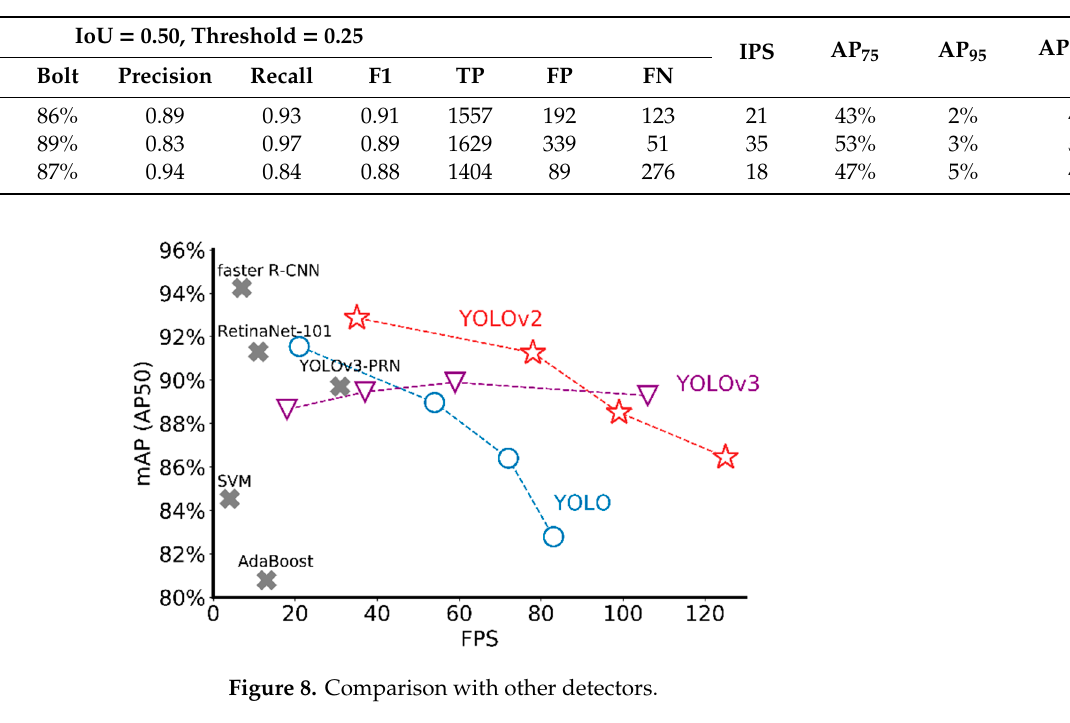
Table 2. Performances on testing data set.